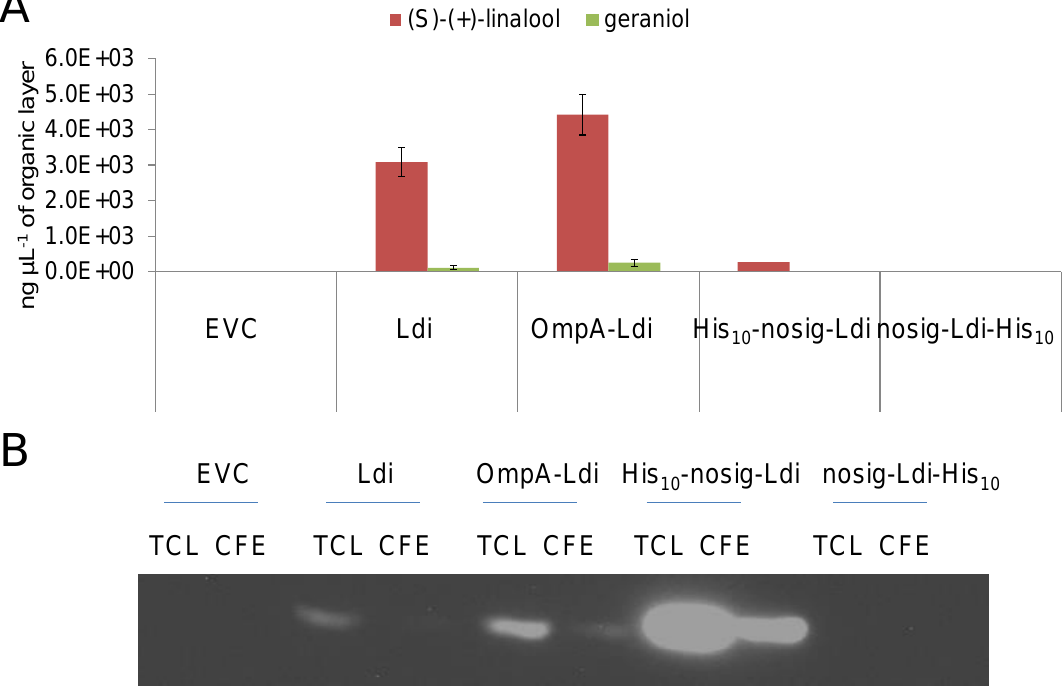
Figure 4. Subcellular targeting impacts the expression and activity of recombinant Ldi in E. coli . The enzyme was located to the periplasm by expressing Ldi constructs harboring either the native N-terminal signal sequence (Ldi) or an N-terminal E. coli OmpA signal sequence (OmpA-Ldi). Cytosolic enzyme localization was targeted with constructs lacking an N-terminal leader peptide (nosig-Ldi; either N- or C-terminally His 10 -tagged). ( A ) Whole-cell biotransformations of β -myrcene with E. coli expressing Ldi. ( B ) Expression analysis of Ldi in total cell lysates (TCL) and cell-free extracts (CFE) of an E. coli empty vector control (EVC), as well as in strains expressing Ldi, OmpA-Ldi, His 10 -nosig-Ldi, and nosig-Ldi-His 10 by